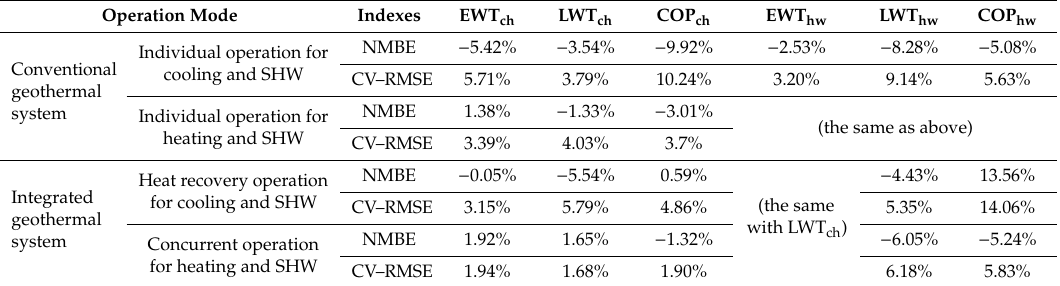
Table 3. Results of the calibration for each operation mode (summarized from